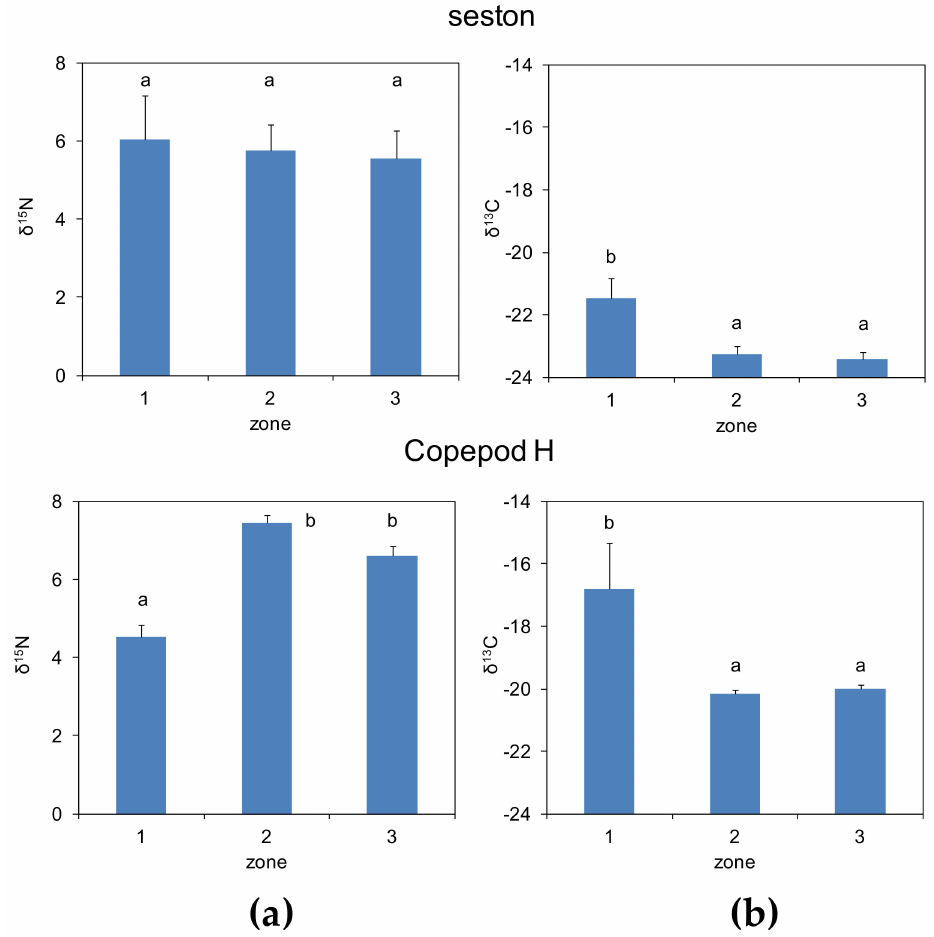
Figure 3. The mean ± SE ( a ) δ 15 N and ( b ) δ 13 C of seston and herbivorous copepods (Copepod H) in the epipelagic layer (surface to 200 m) for the three zones marked in Figure 1. Different letters indicate significantly different zonal means (ANOVA and Dunnett-C post hoc tests, p <